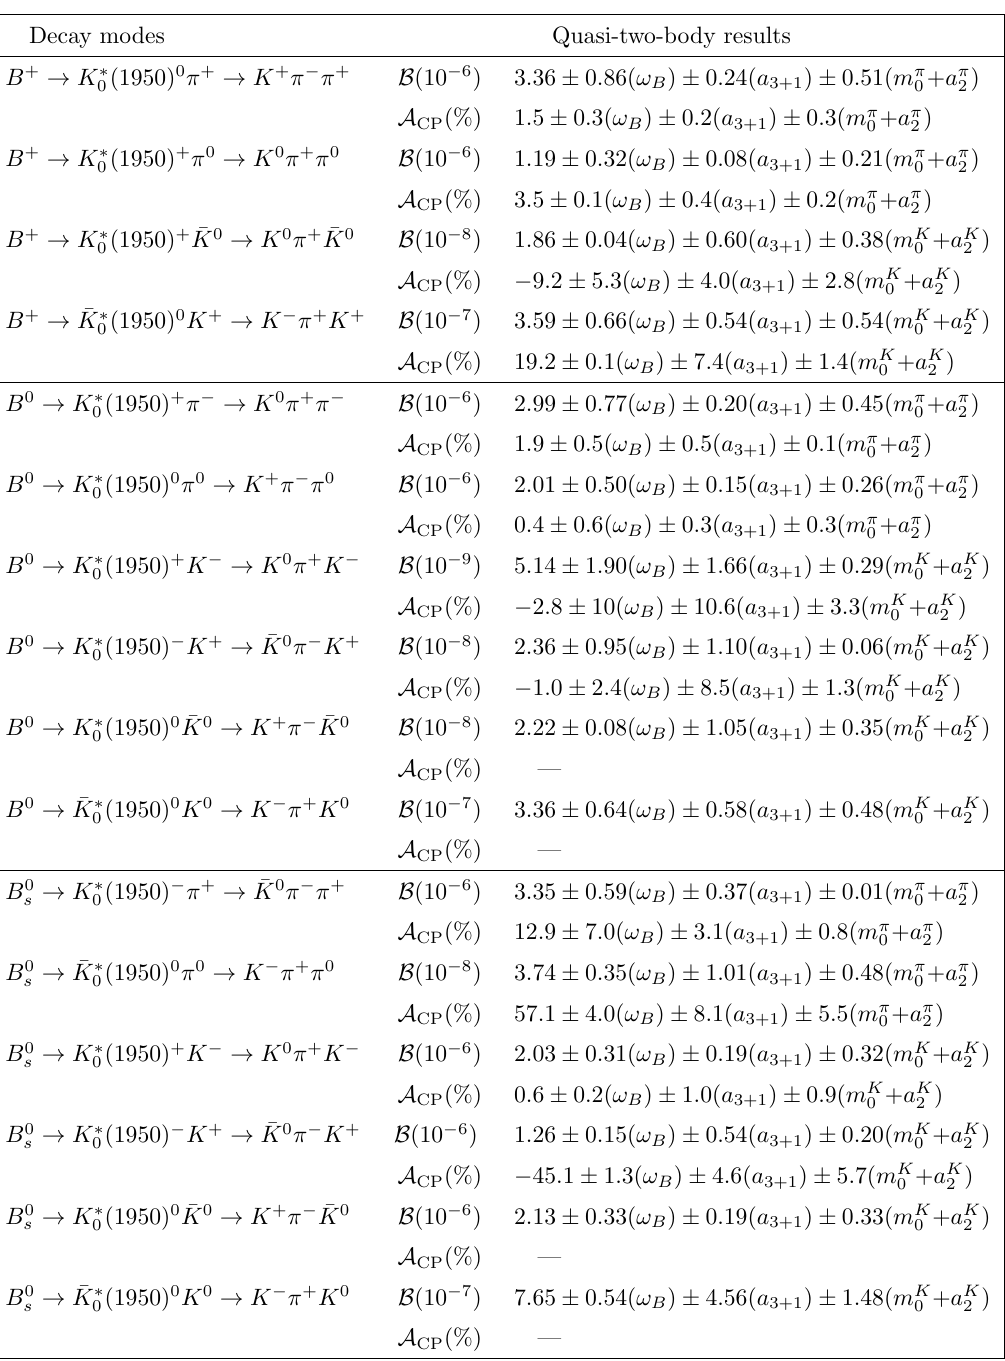
Table 3 . PQCD predictions of the CP averaged branching fractions and the direct CP asymmetries for the quasi-two-body B ! K (cid:3) (1950) h ! K(cid:25)h decays. 0